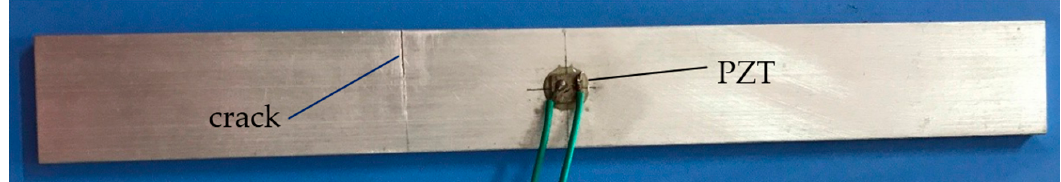
Figure 8. The aluminum plate sample with a crack.